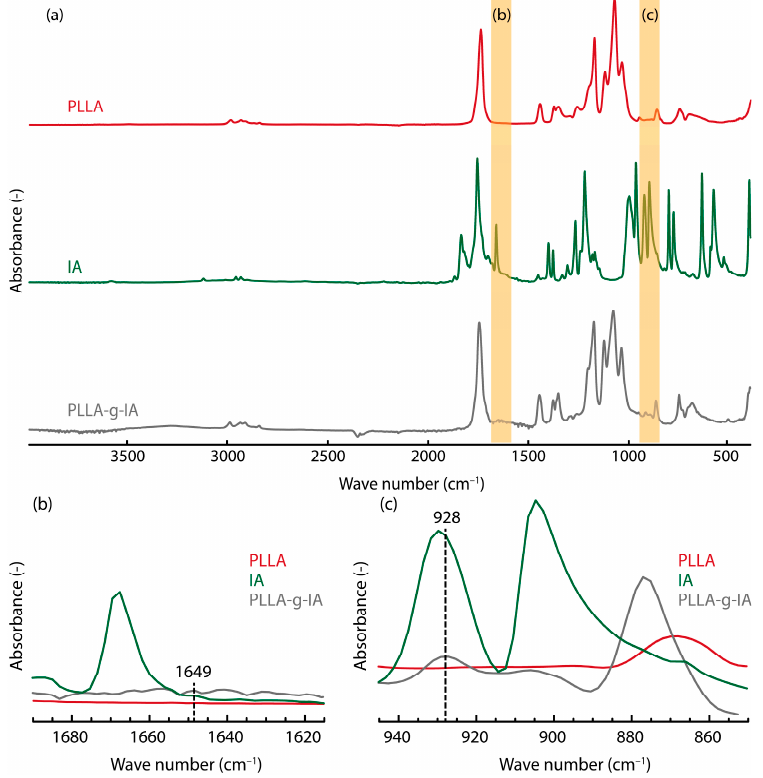
Figure 1. FT-IR spectra of PLLA Luminy L130, IA, and PLLA-g-IA: ( a ) full FT-IR spectrum from 4000 cm − 1 to 400 cm − 1 , ( b ) absorbance of the C=C stretching at 1649 cm − 1 , and ( c ) absorbance of the C-O-C stretching at 928 cm − 1.